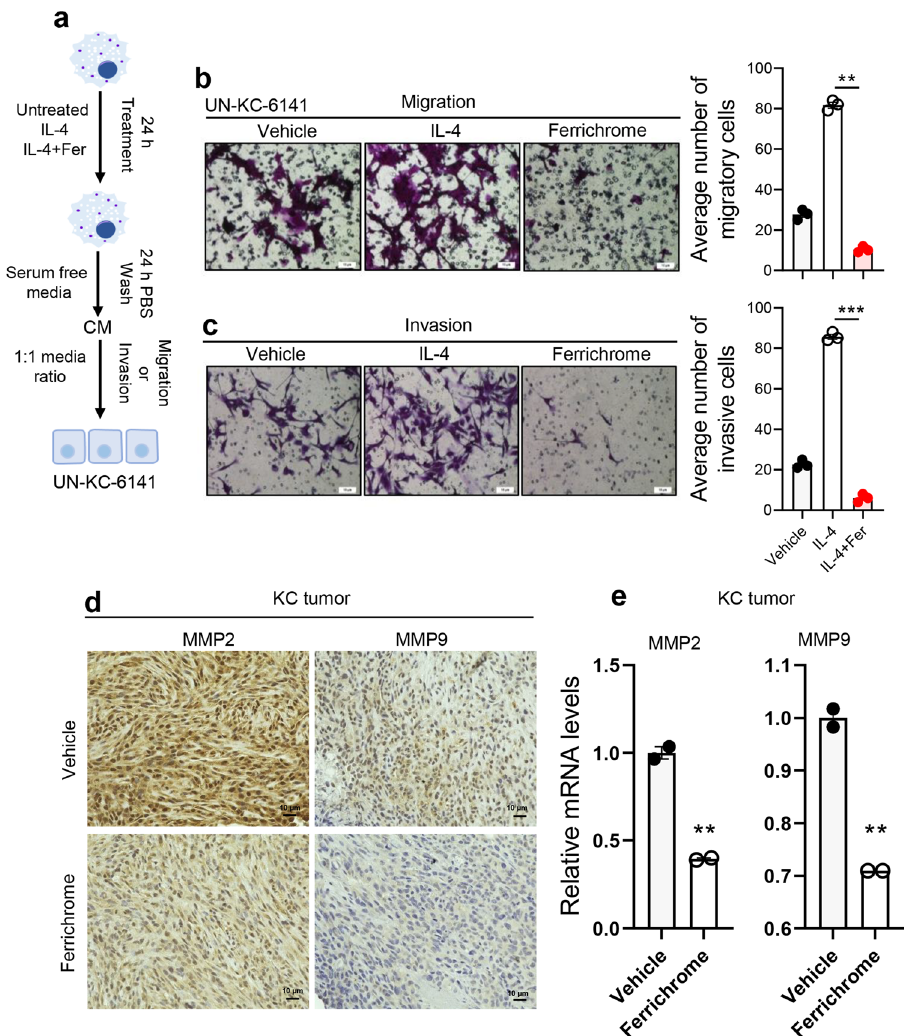
Fig. 4 Ferrichrome abrogates macrophage-mediated cancer cell migration and invasion. a Representative scheme of in vitro experimental design to evaluate the effect of ferrichrome on macrophage-mediated cancer cell migration and invasion. RAW264.7 macrophages were treated with vehicle, IL-4 (20 ng/mL), or ferrichrome + IL-4 for 24 h. Conditioned media (CM) was collected by culturing RAW264.7 cells for an additional 24 h in serum-free RPMI 1640 media. UN-KC-6141 pancreatic cancer cells were treated with CM at a ratio of 1:1 cancer cell media: CM for 24 H, then migration and invasion of cancer cells was evaluated via Boyden Chamber migration and invasion assays. b Representative images and quanti fi cation of migratory cells in # high power fi elds. c Representative image and quanti fi cation of invasive cells in # high power fi elds. d Representative immunohistochemistry images of MMP2 and MMP9 protein expression in tumors treated with either ferrichrome or vehicle ( n = 4 mice). Original Magni fi cations ×400. e Relative gene expression analysis of MMP2 and MMP9 in tumors treated with ferrichrome or vehicle as evaluated by qPCR analysis ( n = 3 experiments). Mean ± SEM shown. ** p < 0.01, and *** p < 0.001 as determined by Student ’ s t